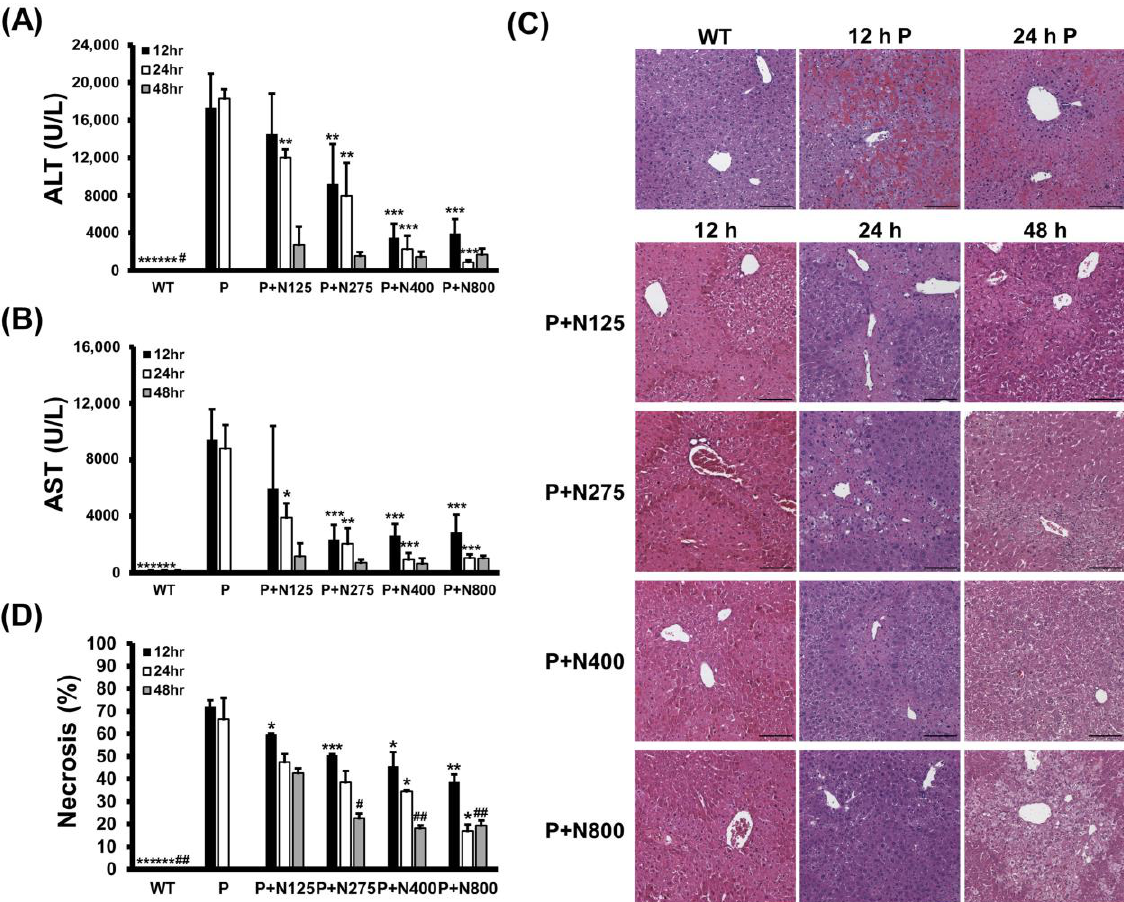
Figure 3. Serum ALT ( A ) and AST ( B ) activities, histopathological images ( C ), and percentages of necrosis ( D ) in liver sections at 12, 24, and 48 h post-P1200 injection and with or without indicated doses of NAC therapies in BALB/c mice. WT: Mice treated with the same volume of phosphate-buffered saline (PBS); P: P1200 injection only; P+N: After P1200 injection, mice were treated with 125 mg/kg (P+N125), 275 mg/kg (P+N275), 400 mg/kg (P+N400), or 800 mg/kg (P+N800) NAC. Significant differences compared with the P group are indicated by * (p < 0.05), ** (p < 0.01), and *** (p < 0.001). Significant differences compared with the P+N125 group are indicated by # (p < 0.05) and ## (p < 0.01). Scale bars: 100 μm.